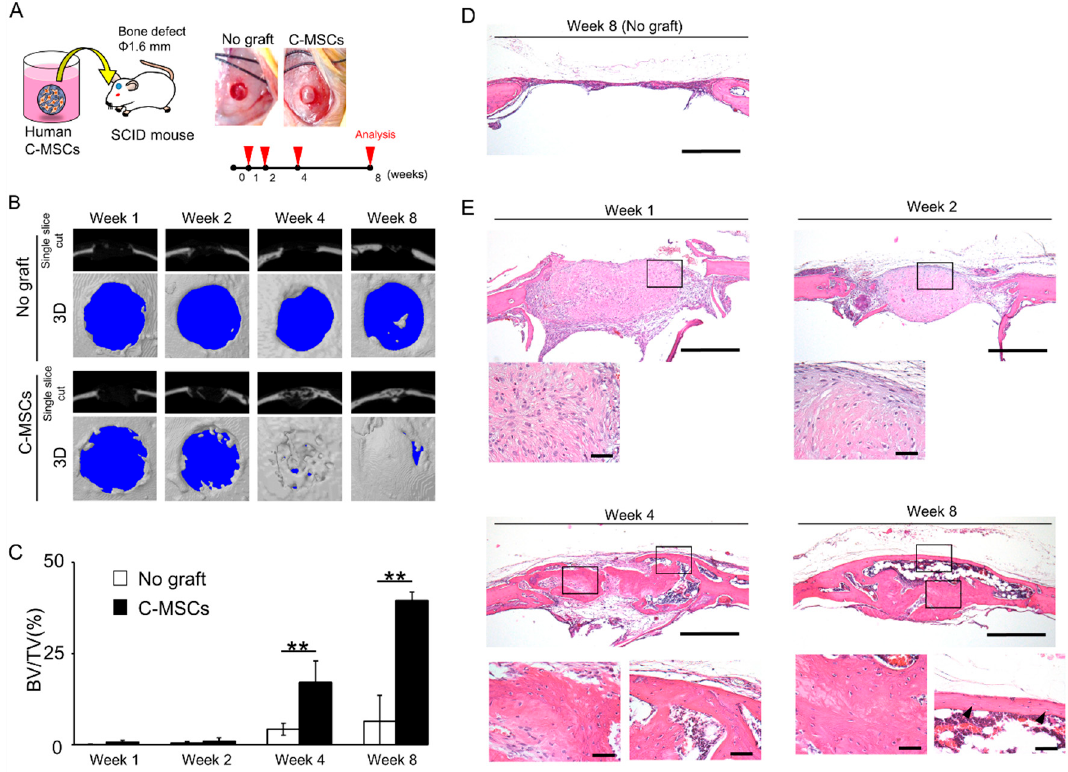
Figure 2. Implantation of C-MSCs generated in xeno-free conditions with no artificial scaffold can induce mouse calvarial bone regeneration. ( A ) Study design for the in vivo experiment. C-MSCs were transplanted into a SCID mouse calvarial defect 1.6 mm in diameter with no artificial scaffold. No graft group was set as a control. ( B ) Representative µCT images at 1, 2, 4, and 8 weeks after surgery. ( C ) Ratio of the segmented bone volume (BV) to the total volume (TV) of the defect region at 1, 2, 4, and 8 weeks following surgery. Data are mean ± SD of four mice per group. ** p < 0.01 for each respective time point. ( D – H ) Animals were sacrificed at 1, 2, 4, and 8 weeks after surgery and the calvarial bones were fixed. Coronal sections were obtained and stained with H&E. ( D ) No graft group at 8 weeks after surgery. Bar = 500 µm. ( E ) C-MSCs grafted group at 1, 2, 4, and 8 weeks following transplantation. Bar = 500 µm. Bottom panels are magnifications of the boxed regions. Bar = 50 µm. The photographs are representative of four independent experiments.